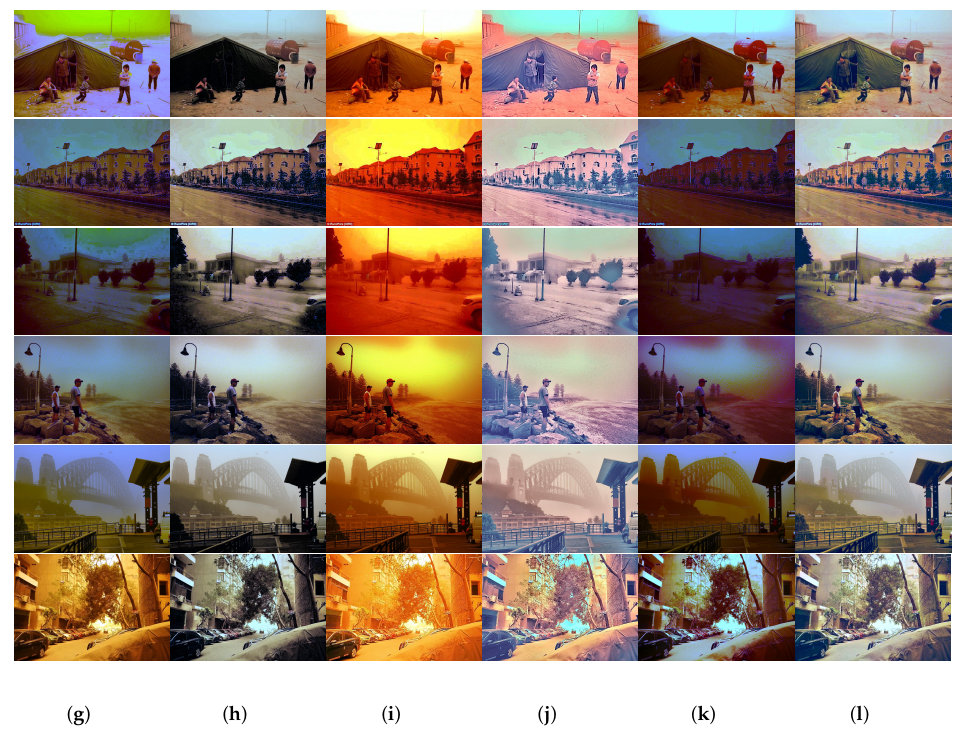
Figure 7. Qualitative comparison results of various sand storm images: ( a ) Sanddust Images; ( b ) TFO [9]; ( c ) NGT [11]; ( d ) BCGF [13]; ( e ) AWC [17]; ( f ) VRSI [19]; ( g ) SBT [20]; ( h ) FBE [29]; ( i ) GDCP [30]; ( j ) HDCP [31]; ( k ) RBCP [32]; ( l )